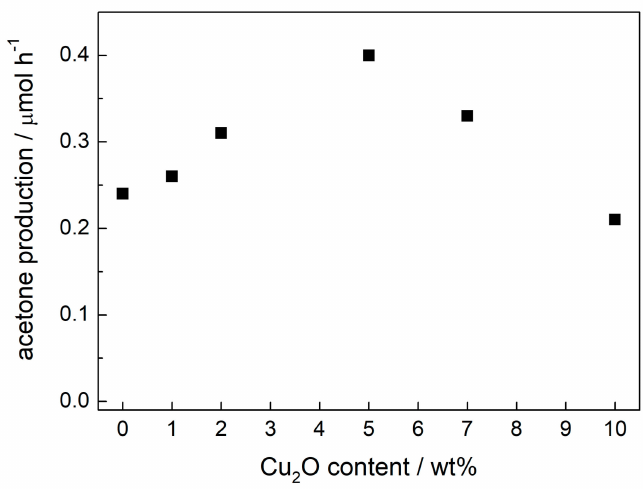
Figure 2. Visible light photocatalytic activity of the samples prepared with different Cu 2 O content.